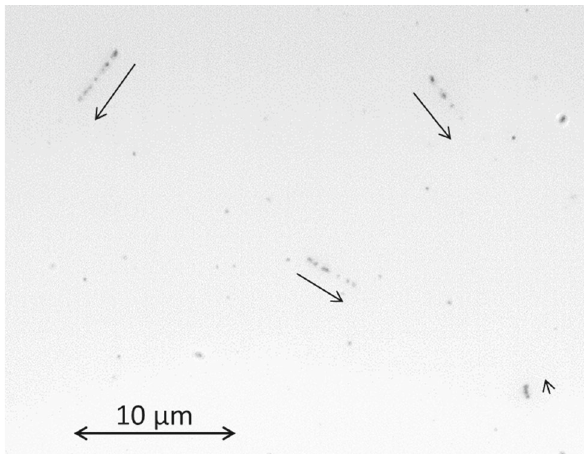
Fig. 3 Tracks from neutron absorption by 10 B were clearly observed under the epi-illumination optical microscope. Arrows are drawn next to tracks. Beginning points of the arrows show starting points of tracks at the surface of the converter